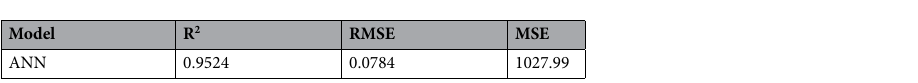
Table 5. Error and R 2 (RSQ), RMSE (ton), and MSE (ton) in testing datasets of ANN